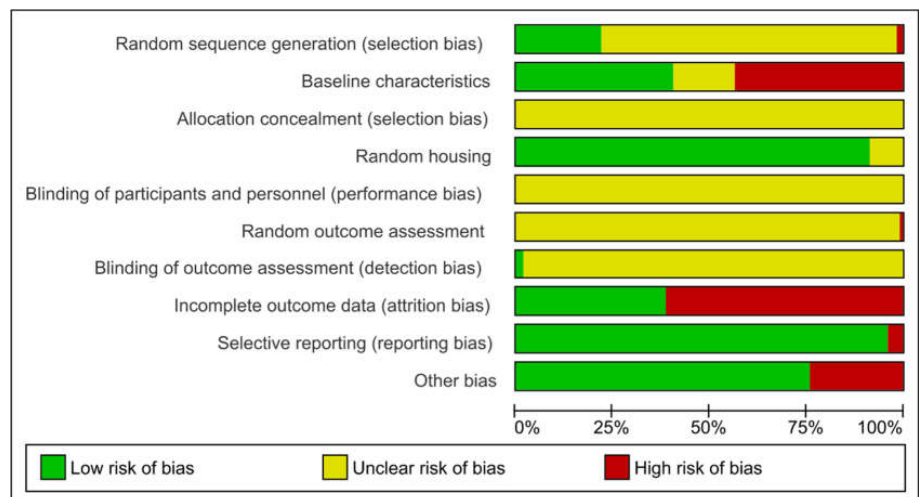
Figure 5. Risk of bias assessment for the 125 studies included.